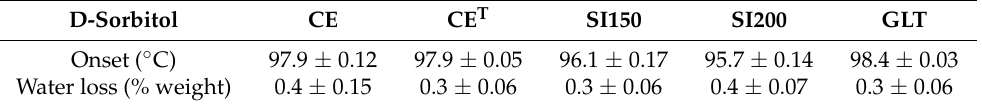
Figure 5. TGA thermal decomposition profile of D-Sorbitol CE, CE T , SI150, SI200 and GLT pow- ders [41]. Table 4. Summary of thermal